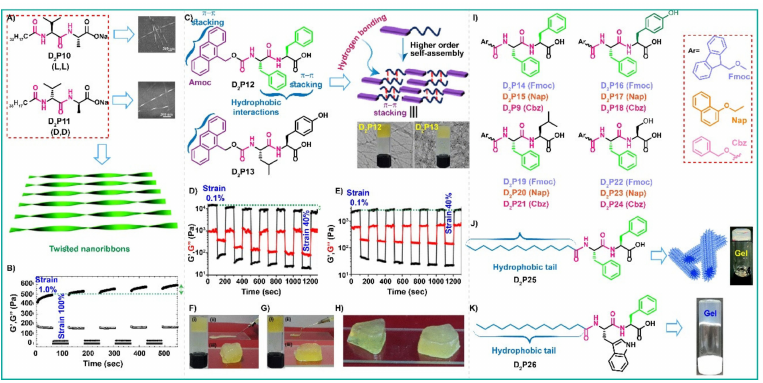
Figure 7. ( A ) Molecular structures and FE-SEM images of the lipodipeptide hydrogelators (D 2 P10 and D 2 P11); Schematic illustration of twisted nanoribbons. ( B ) Rheological step-strain measurements of the respective lipodipeptide hydrogels; reproduced with permission from Ref. [78]. Copyright (2018) Royal Society of Chemistry. ( C ) Chemical structures, schematic illustration for self-assembly to form the gels and TEM images of the resultant hydrogels. ( D , E ) Thixotropy test of the dipeptide (D 2 P12 and D 2 P13) hydrogel. ( F , G ) Self-supporting hydrogel images: (i) inverted vial confirming gelation character; (ii) injectable nature of the hydrogels; (iii) macroscopic hydrogel block; ( H ) macroscopic- shaped (triangular and pentagonal) hydrogel; reproduced with permission from Ref. [79]. Copyright (2018) American Chemical Society. ( I ) Molecular structure of the self-assembled peptide